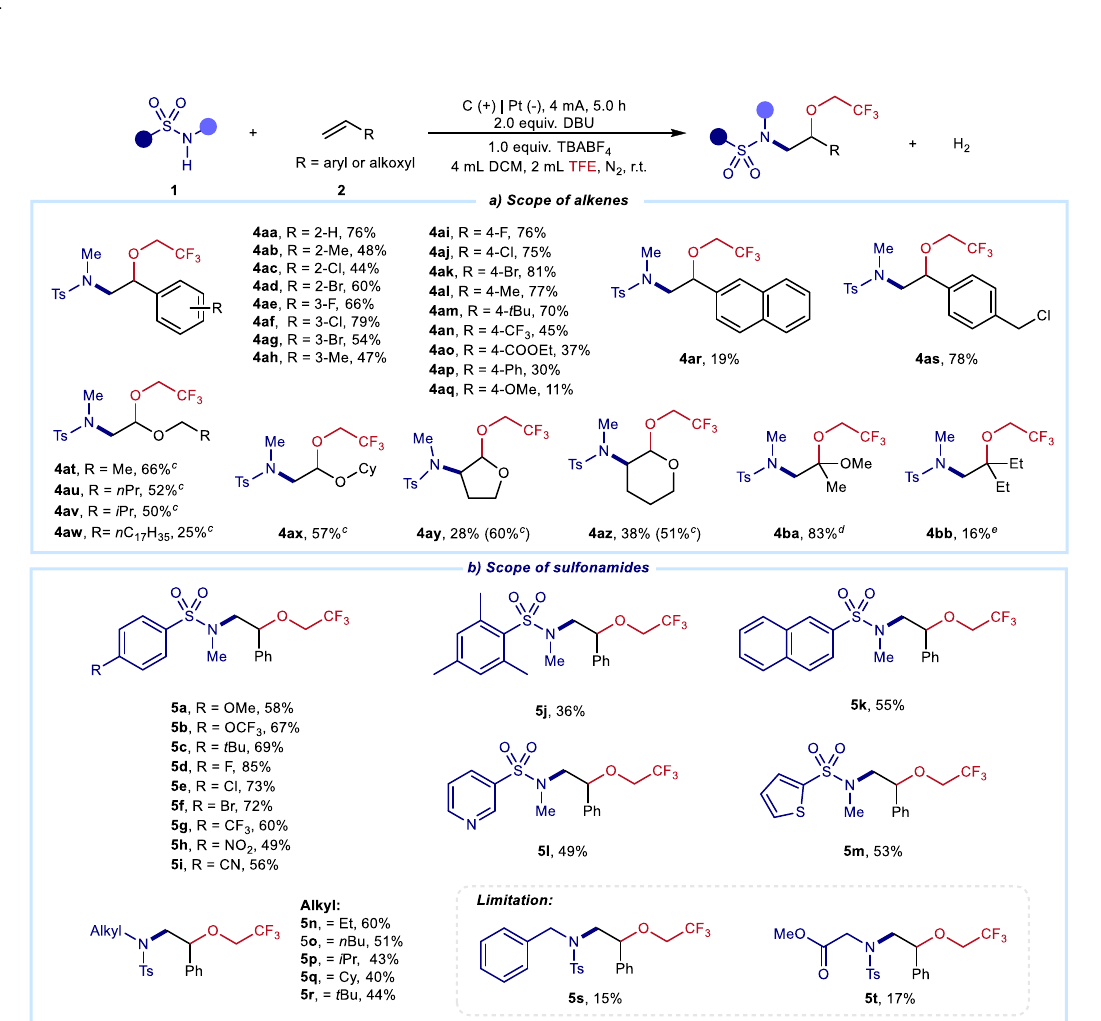
N 2 . b Scope of sulfonamides. c Alkenes (1.8mmol, 6 equiv.) were used. d Constant current=5mA, 6h, DBU (0.39mmol, 1.3 equiv.). e Alkenes (3.0mmol, 10 equiv.) were used. All yields are isolated